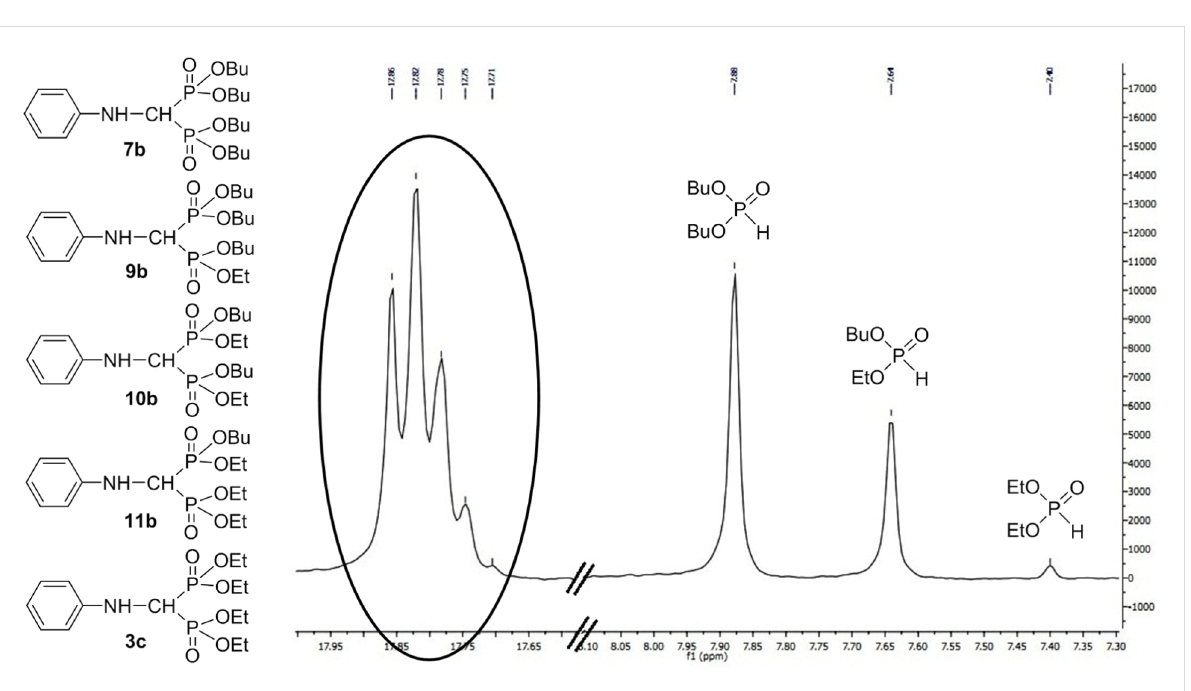
Figure 3: 31 P NMR spectrum for the condensation of aniline, triethyl orthoformate and 2 equivalents of dibutyl phosphite (from the exp. marked by Table 6, entry